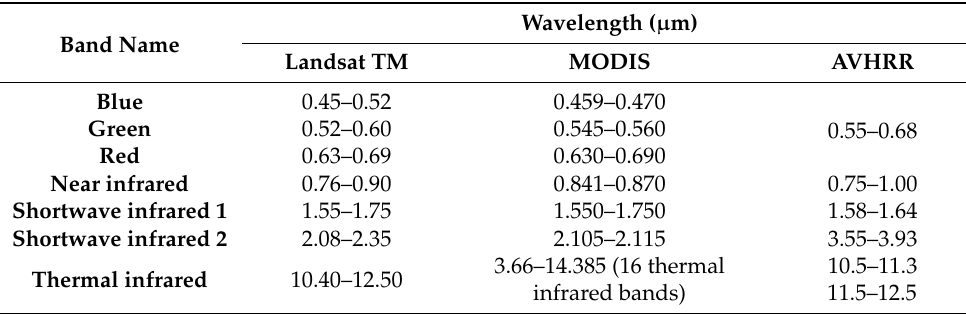
Table 1. Wavelength of different satellite